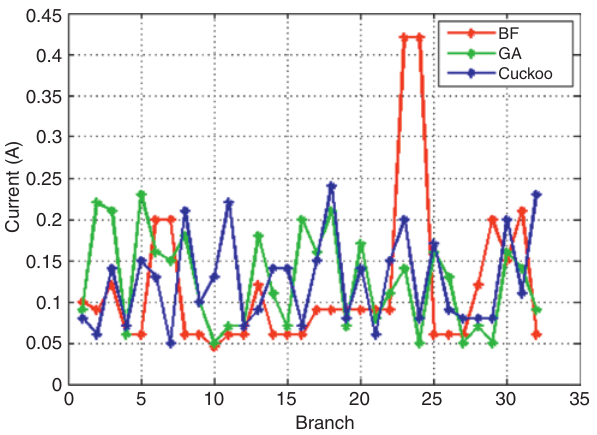
Figure 7: Current Profile Comparison between the Proposed and Existing Methods.